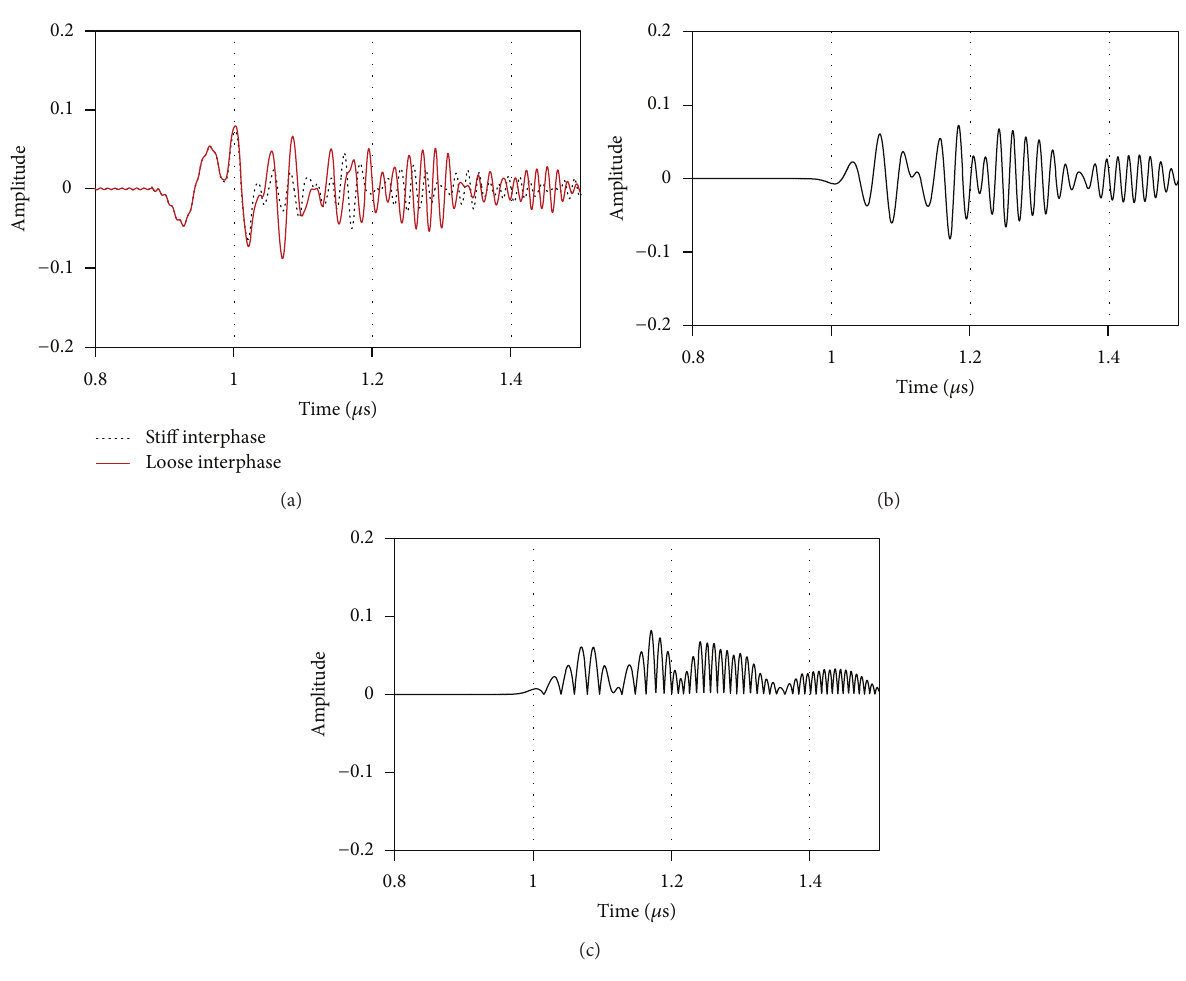
Figure 7: (a) Part of the waveform containing the reflection from the fiber for stiff ( 𝐶 𝑖 = 11770 m/s) and loose ( 𝐶 𝑖 = 300 m/s) interphase. (b) Subtraction of the two waveforms of (a). (c) Rectification of the waveform of (b).